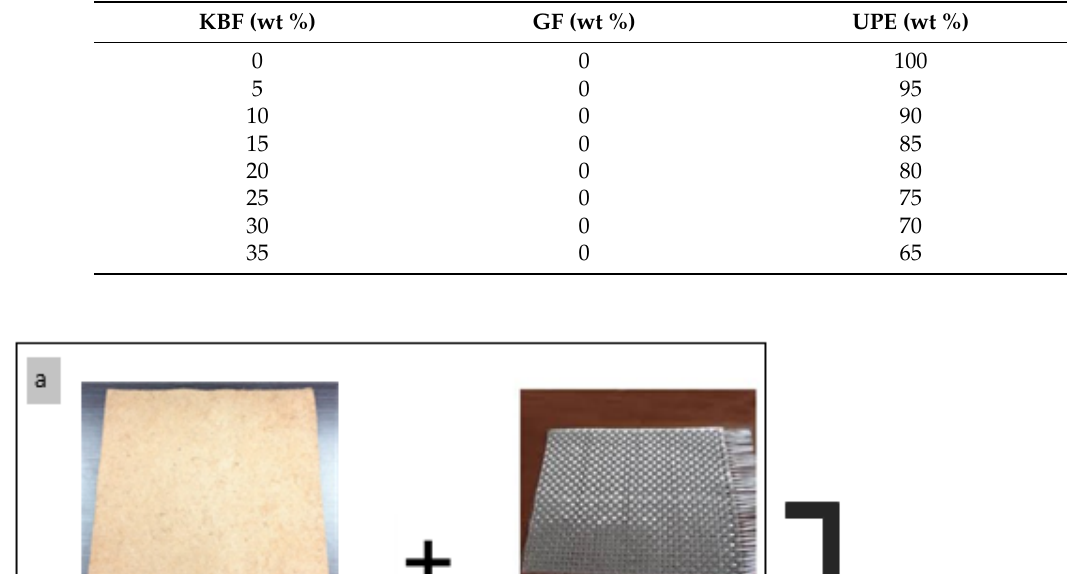
Figure 2. Sequence of ( a ) KBF + 5 wt % of GF and; ( b ) KBF + 10 wt % of GF for composite prepara- tion. 3. Testing and Characterization 3.1. Tensile Test The composites were cut into dimensions of 100 mm × 25 mm × 5 mm for test speci- mens. The tensile test was conducted using the 3382A floor model universal testing sys- tem, US, according to ASTM D3039/ D3039M-17 [47]. Figure 3 shows the tensile load di- rection for the hybrid composite sample.